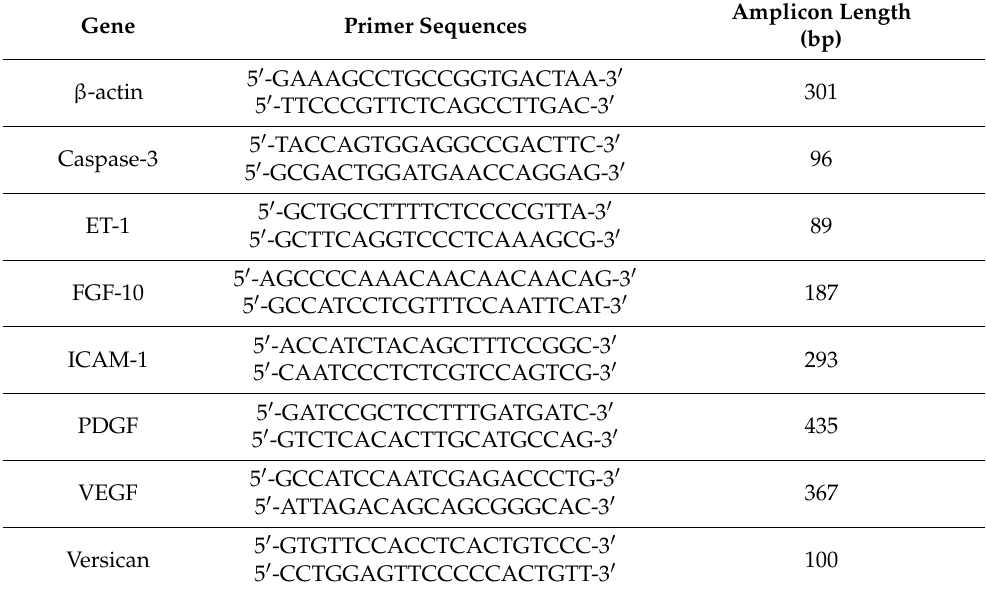
Table 2. PCR primer sequences. ET-1, Endothelin-1; FGF-10, Fibroblast growth factor 10; ICAM-1, Intercellular adhesion molecule 1; PDGF, Platelet-derived growth factor; VEGF, Vascular endothelial growth